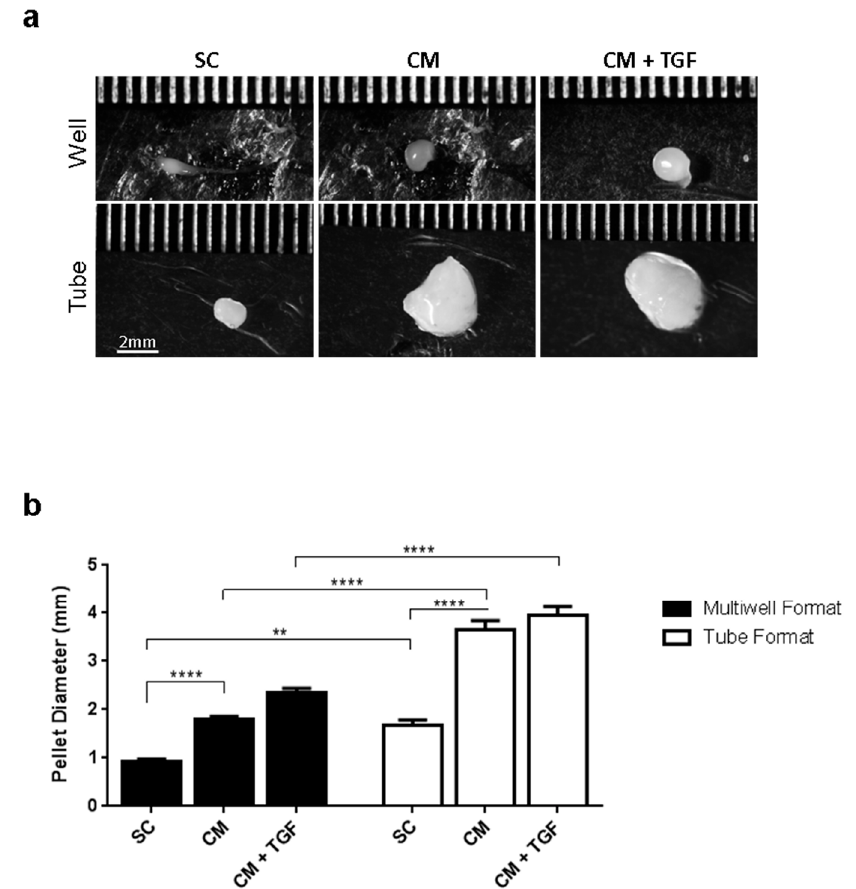
Figure 4. Analysis of chondrogenic pellets after 21 days culture using the micropellet plate method (blue) or the 15 mL falcon method (red). ( a ) Microscopic examination. ( b ) Size of chondrogenic pellets cultured measured along the diameter. The distance between the linear ruler marks is 0.5 mm. ** p < 0.01, **** p < 0.0001 ( n = 4). SC: standard culture medium, CM: chondrogenic differentiation medium, CM + TGF: chondrogenic medium supplemented with TGF- β 1.